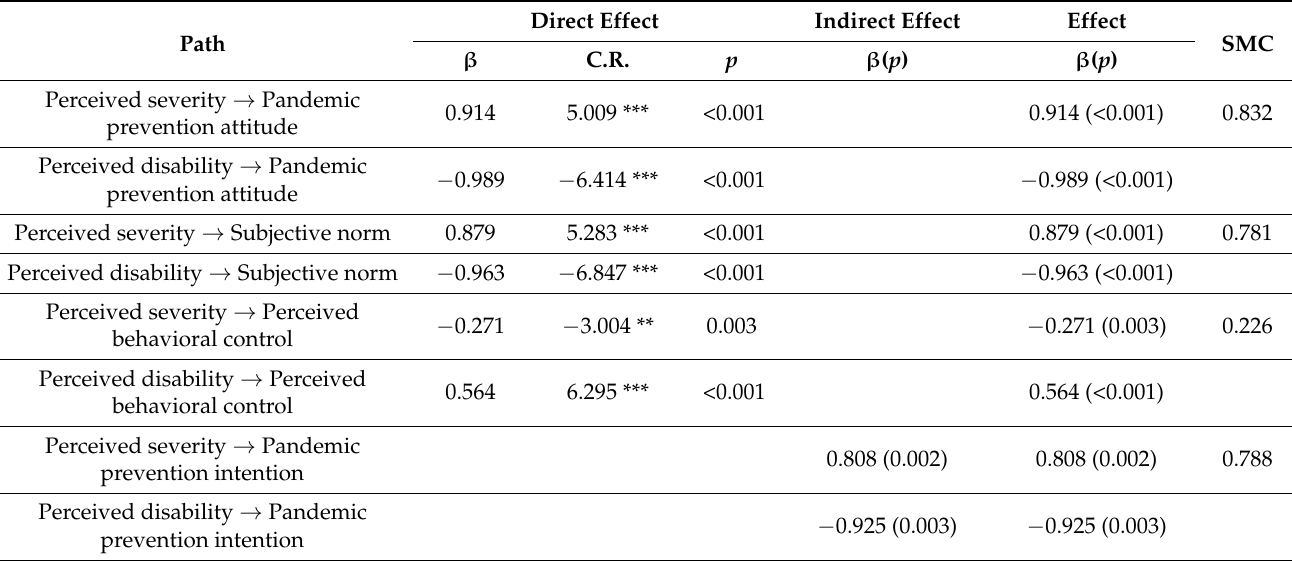
Table 4. Parameter estimation and effect analysis of the structural